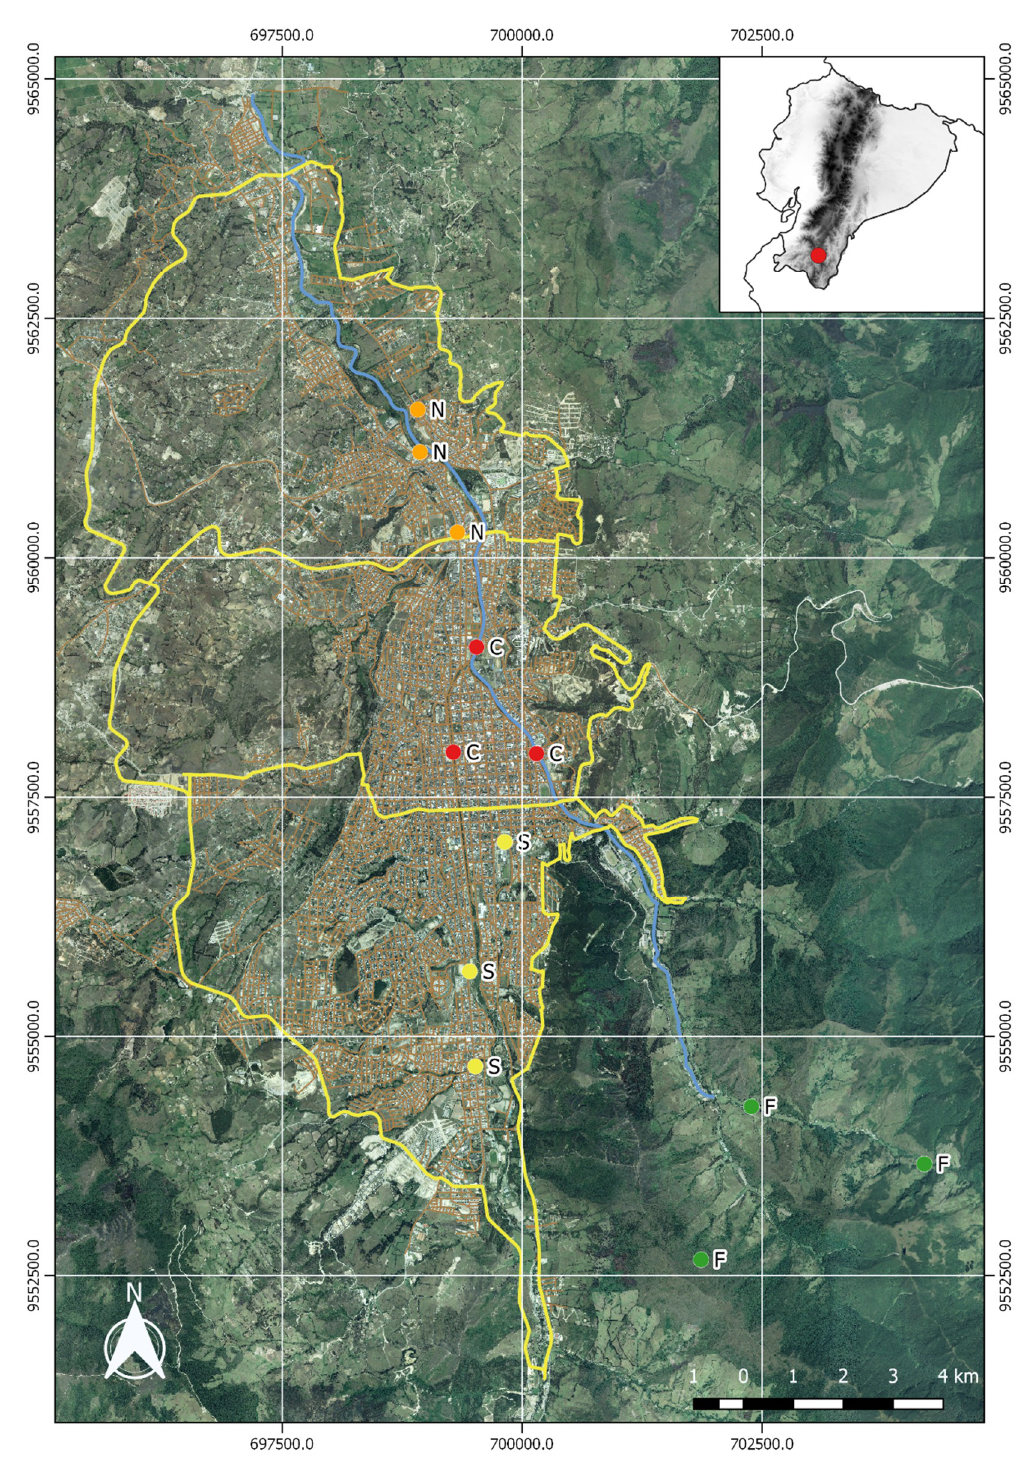
Figure 1. Study area in Loja Province (city of Loja), Southern Ecuador, showing the location of study sites for different levels of air pollution: Forests (F); South (S); Center (C) and North (N).